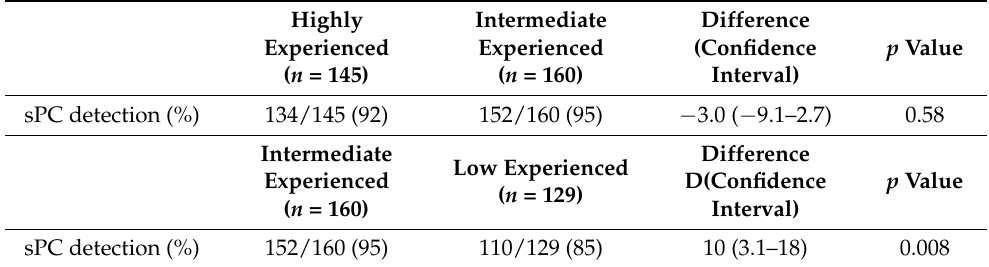
Table 3. Detection of significant prostate cancer by targeted fusion-biopsy and stratified to different experience combined for both fusion-biopsy approaches. sPC = significant prostate